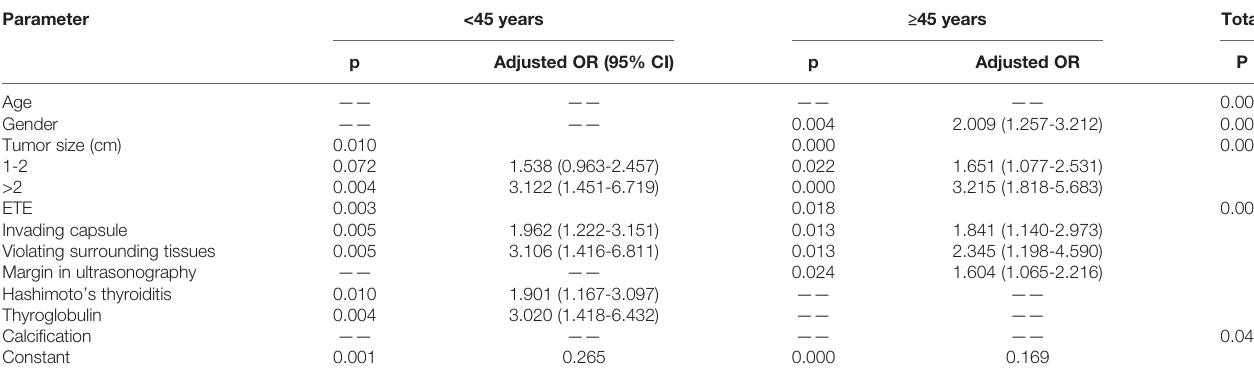
TABLE 3 | Predictive factors of CLNM in PTC patients in multiple logistic regression analysis.